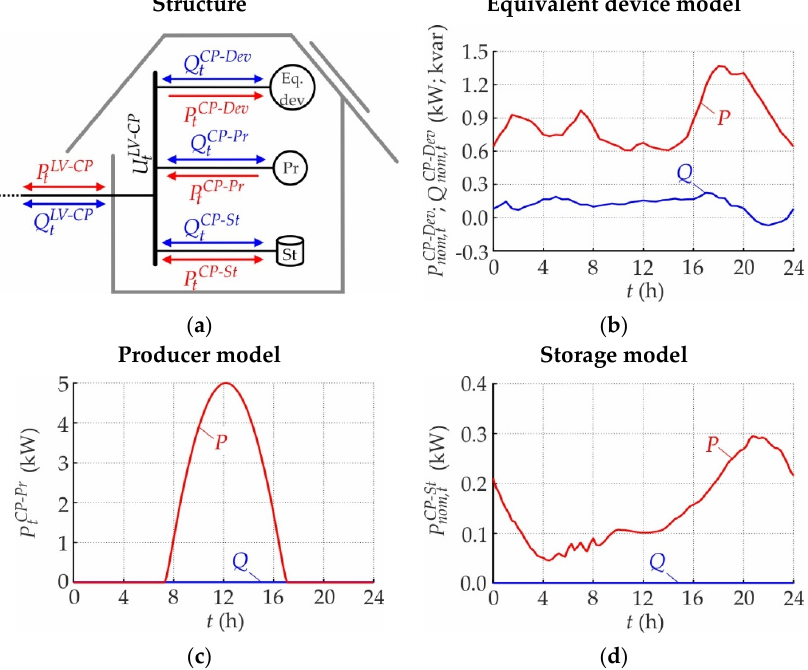
Figure 7. Rural residential CP: ( a ) structure; ( b ) load profiles of the Dev.-model; ( c ) production profiles of the Pr.-model; ( d ) load profiles of the St.-model. The Pr.-model represents the PV system with a module rating of 5 kW and an inverter rating of 5.56 kVA. Its active power production ( P CP − Pr ) is determined by the production profile shown in Figure 7c and is independent of the voltage at the corresponding DP. The reactive power contribution ( Q CP − Pr ) of the Pr.-model is set to zero as no Volt/var is considered. Module and inverter losses are neglected. The St.-model represents an EV battery that is connected to the CP through the EV charger. By analogy with the Dev.- model, the active power absorbed by the charger is specified using ZIP models from [27] and load profiles from [28], see Equation (3a) and Figure 7d. Its reactive power contribu- tion is set to zero.